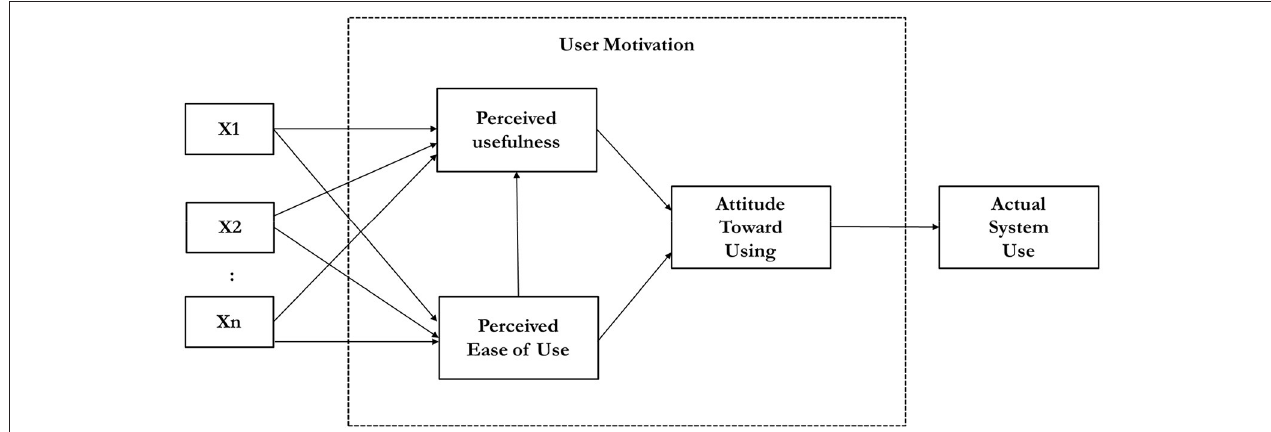
FIGURE 1 | The technology acceptance model (Davis, 1986; cited in Lai,